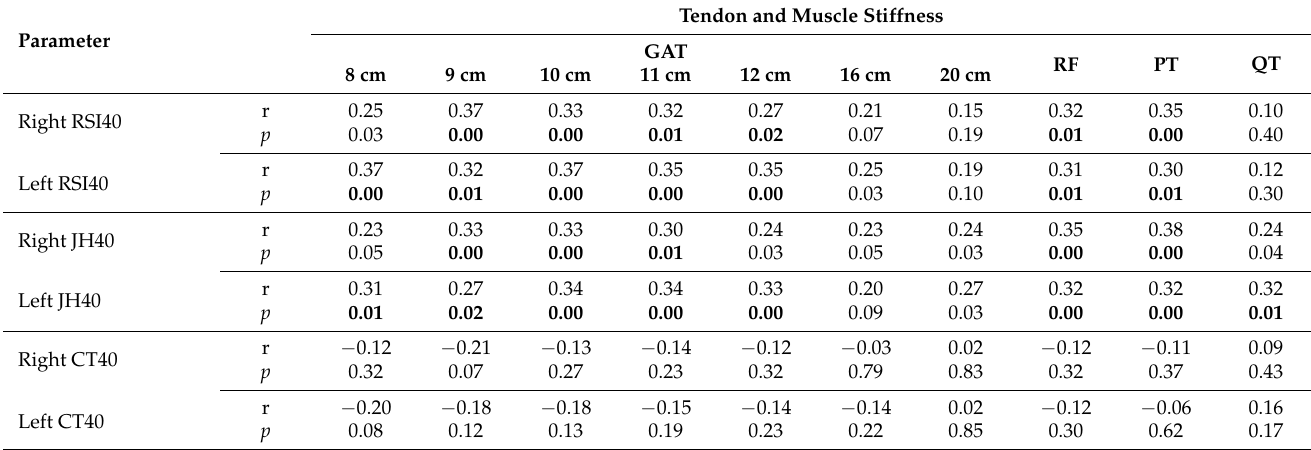
Table 4. Correlations between DJ40 performance and stiffness parameters (mean ±